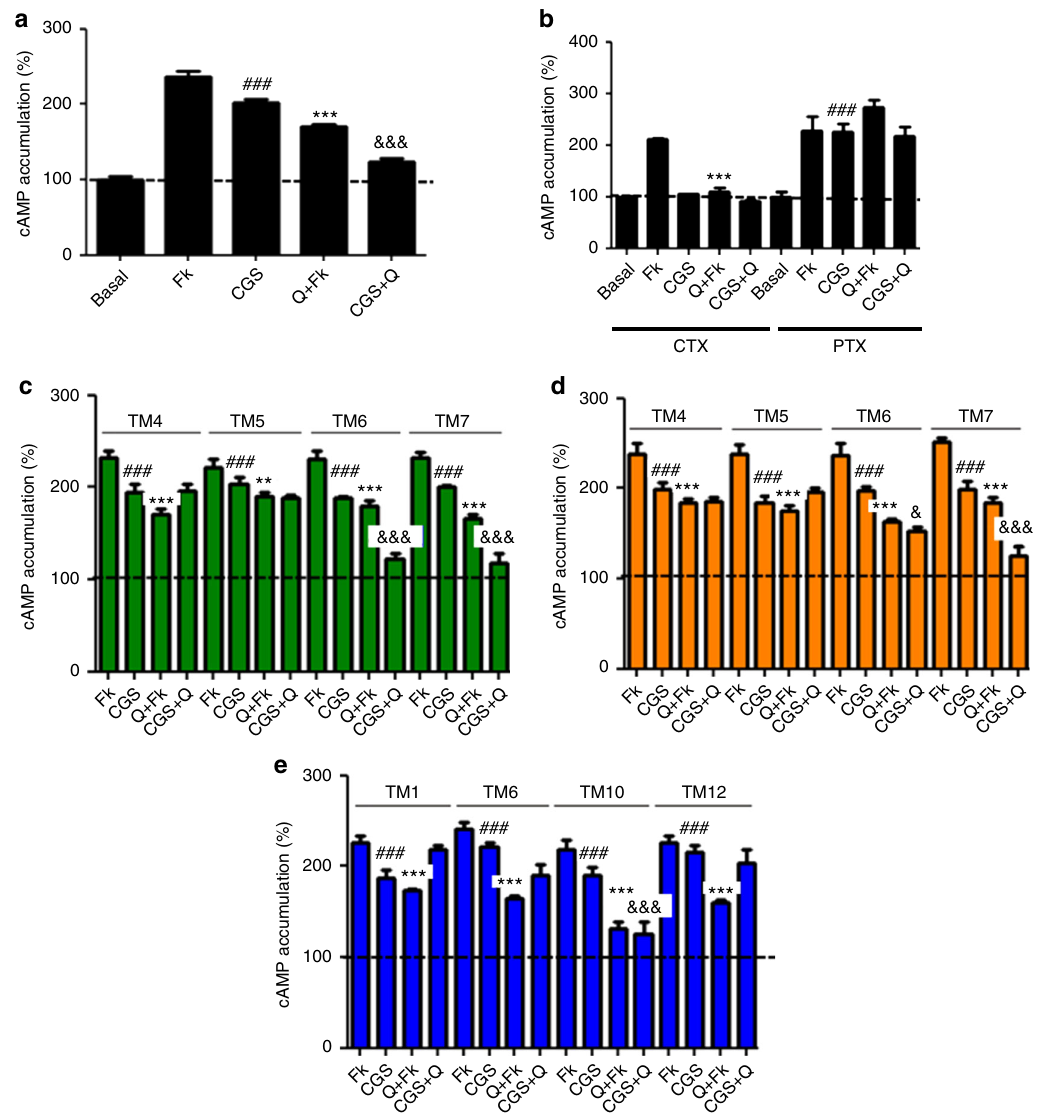
Fig. 6 Canonical Gs – Gi antagonistic interaction in striatal neurons in culture. a , b cAMP production determined in rat striatal primary cultures incubated overnight with vehicle ( a ) or with pertussis toxin (PTX; 10 ng/ml), or for 2 h with cholera toxin (CTX; 100 ng/ml) ( b ), and exposed to CGS21680 (CGS; 100 nM), quinpirole (Q; 1 μ M) or both in the absence or in the presence of forskolin (Fk; 0.5 μ M), respectively. c – e cAMP production determined in rat striatal primary cultures incubated 4 h with 4 μ M of indicated TM peptides of A 2A R ( c ), D 2 R ( d ), or AC5 ( e ) and exposed to agonists as in a , b . Values (in means ± SEM) are expressed as percentage of cAMP accumulation in non-treated cells (basal) ( n = 5 – 7, with triplicates); ### p < 0.001, as compared to basal values; ** and *** p < 0.01 and p < 0.001 as compared to Fk, respectively; & , &&& p < 0.05 and p < 0.001 as compared to CGS, respectively;